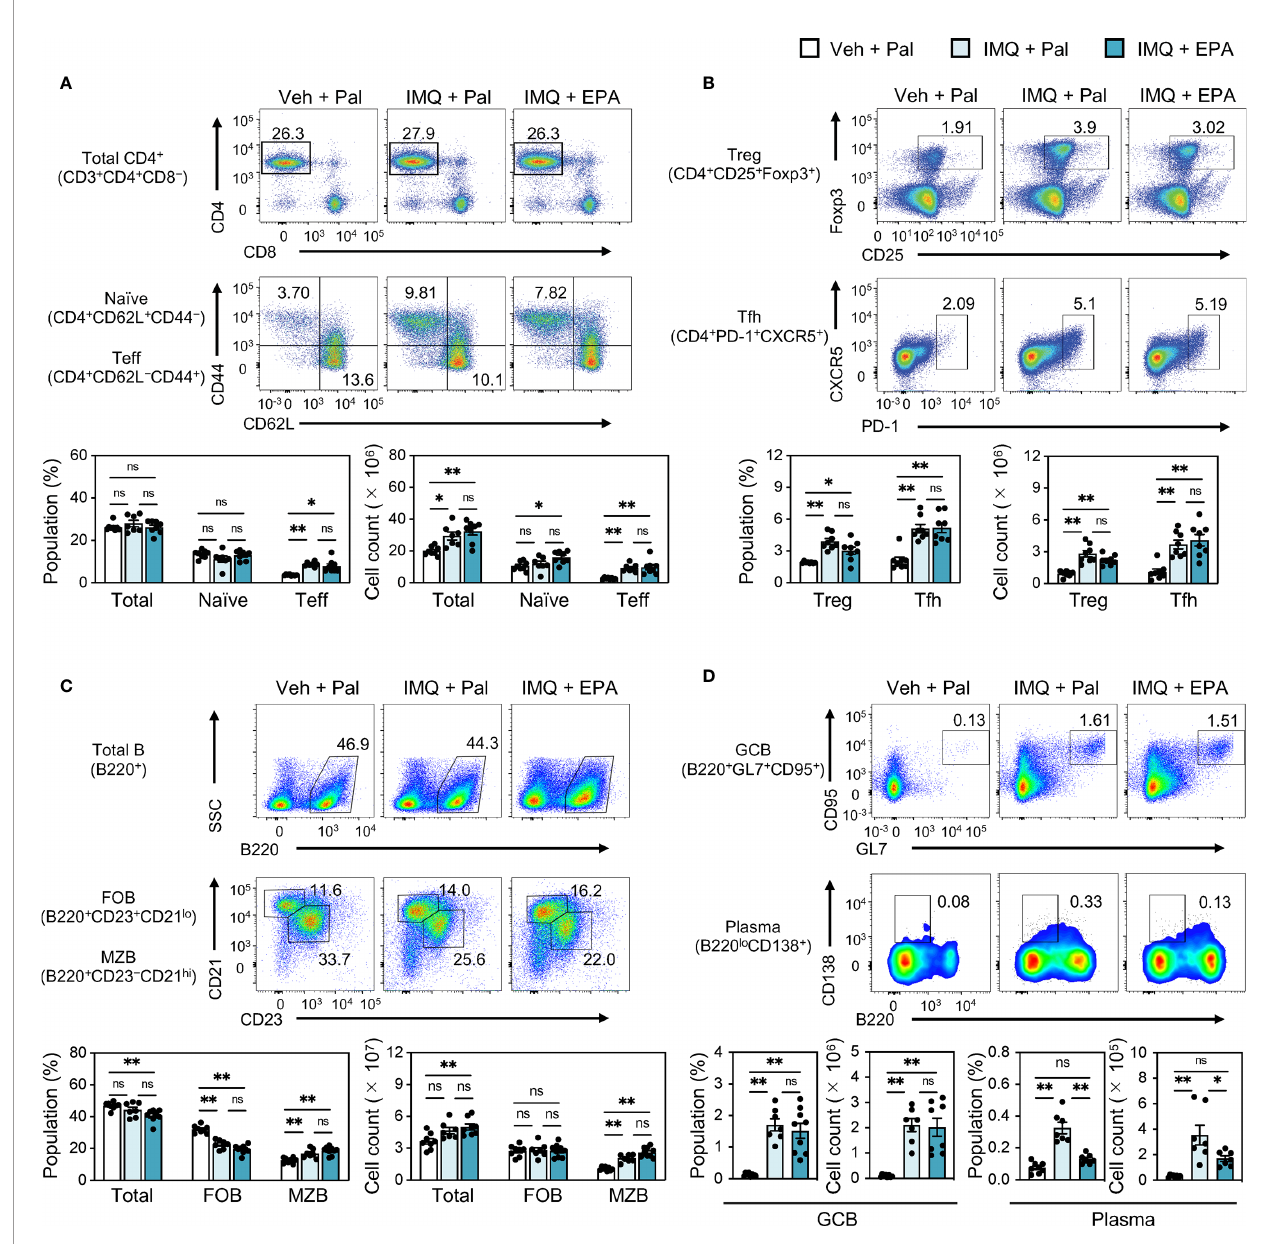
FIGURE 2 | EPA reduces plasma cell counts in spleen of IMQ-induced lupus mice. Immunophenotyping of spleen from Veh-treated mice fed Pal-supplemented diet, IMQtreated mice fed Pal-supplemented diet, and IMQ-treated mice fed EPA-supplemented diet by fl ow cytometry. Gating strategy is available in Figure S2 . (A, B) Representative fl ow cytometry plots (top), percentages (bottom, left) and cell counts (bottom, right) of CD4 + T cell subsets in total spleen cells. Total CD3 + CD4 + T cells, CD4 + CD62L + CD44 − naïve T cells and CD4 + CD62L − CD44 + effector T cells (Teff) (A) , CD4 + CD25 + Foxp3 + regulatory T cells (Treg) and CD4 + PD- 1 + CXCR5 + follicular helper T cells (Tfh) (B) were analyzed. (C) Representative fl ow cytometry plots (top), percentages (bottom, left) and cell counts (bottom, right) of B220 + B cell subsets in total spleen cells. Total B220 + B cells, B220 + CD23 + CD21 lo follicular B cells (FOB), B220 + CD23 − CD21hi marginal zone B cells (MZB) were analyzed. (D) Representative fl ow cytometry plots (top), percentages and cell counts (bottom) of B cell subsets in total spleen cells. B220 + GL7 + CD95 + germinal center B cells (GCB) and B220 lo CD138 + plasma cells (Plasma) were analyzed. Veh + Pal, n = 8; IMQ + Pal, n = 8; IMQ + EPA, n = 9. Data shown are mean value ± SEM of representative experiments at least three times independently. Statistical analysis was performed with Dunn ’ s test ( A : Teff) or Tukey ’ s test (if not otherwise stated). *p < 0.05; **p < 0.01; ns, not signi fi cant. See also Figure S2 and S3